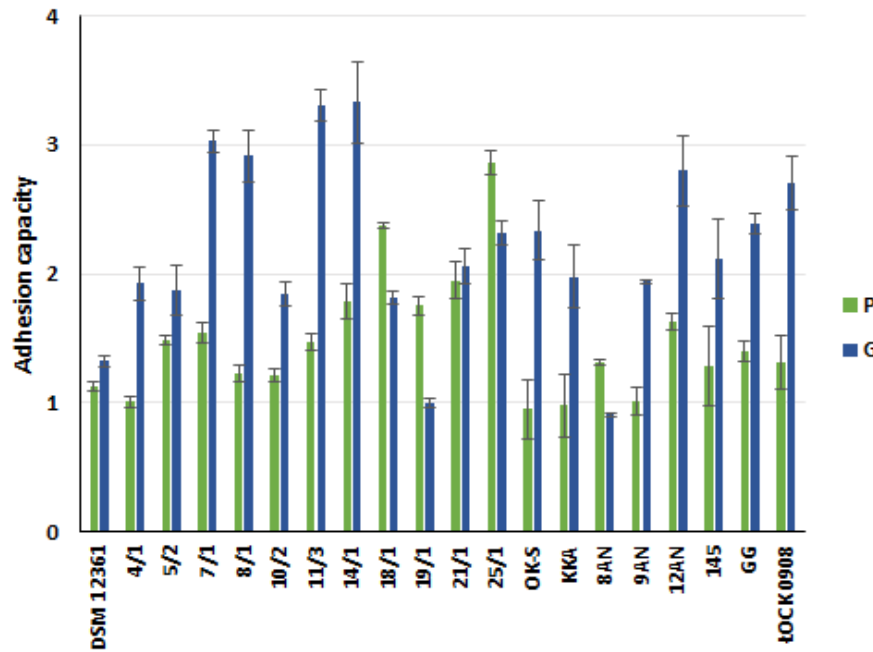
Figure 1. The capacity of lactic acid bacteria (LAB) to adhere to abiotic surfaces. Adhesion capacity: A ≤ 1 no adhesion; 2 ≥ A > 1 weak adhesion; 3 ≥ A > 2 medium adhesion; A > 3 strong adhesions. Each data point represents the means from four individual wells. Results are presented as mean ± standard deviation (S.D.).